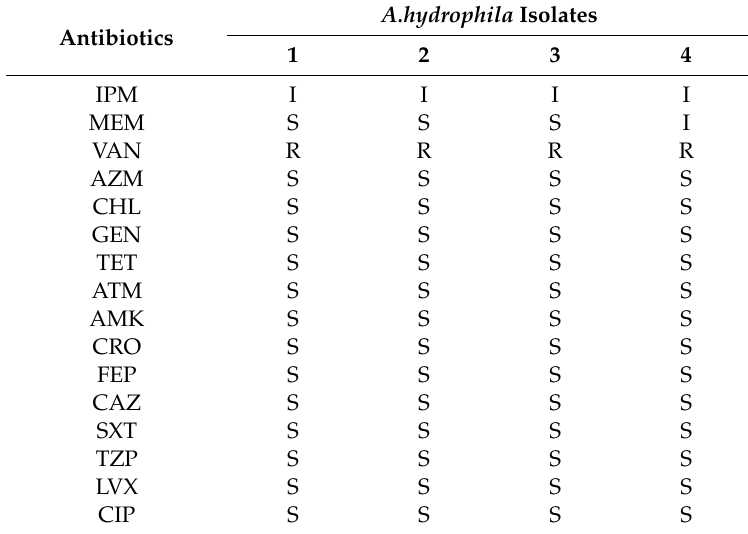
Table 2. Susceptibility of A. hydrophila isolates from